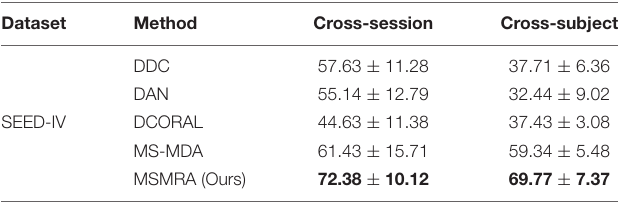
TABLE 4 | Comparisons of the average accuracies and standard deviations of cross-session and cross-subject scenarios on SEED-IV database among the various methods.